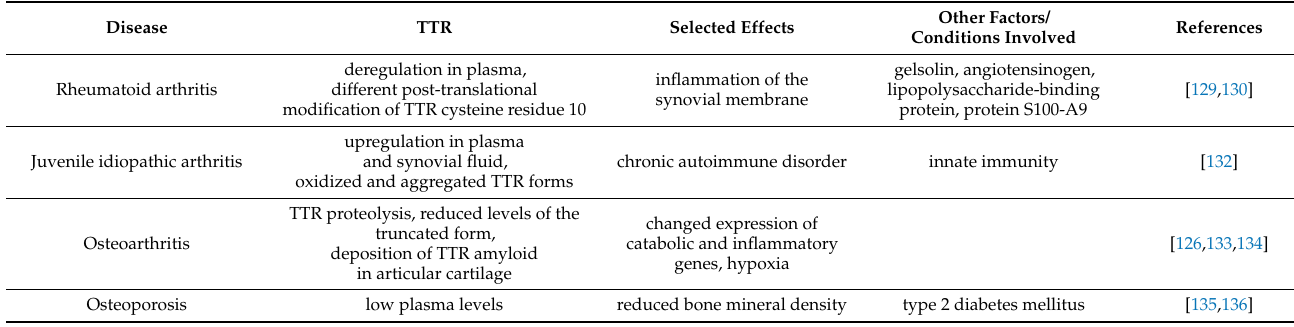
Table 1. Osteoarticular diseases involving